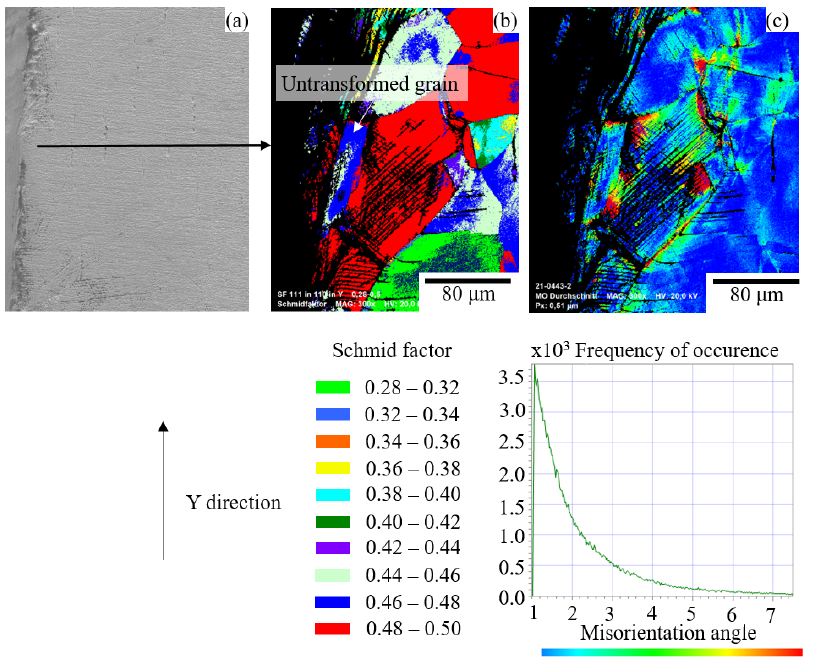
Figure 12. EBSD analysis of a specimen cut at − 110 ◦ C: ( a ) SEM picture, ( b ) Schmid factor analysis of a non-transformed grain in Y direction for < 111 > in { 110 } and ( c ) GAM for 1–7.5 ◦ misorientation